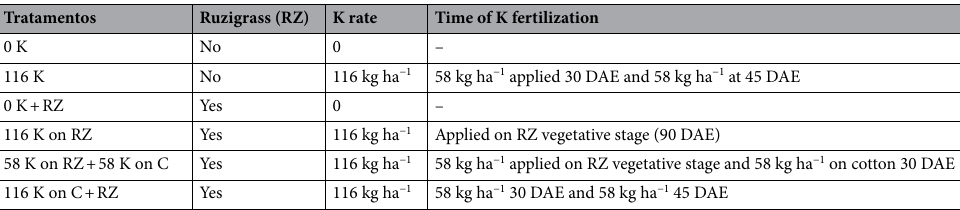
Table 4. Scheme of cotton K fertilization. DAE days after